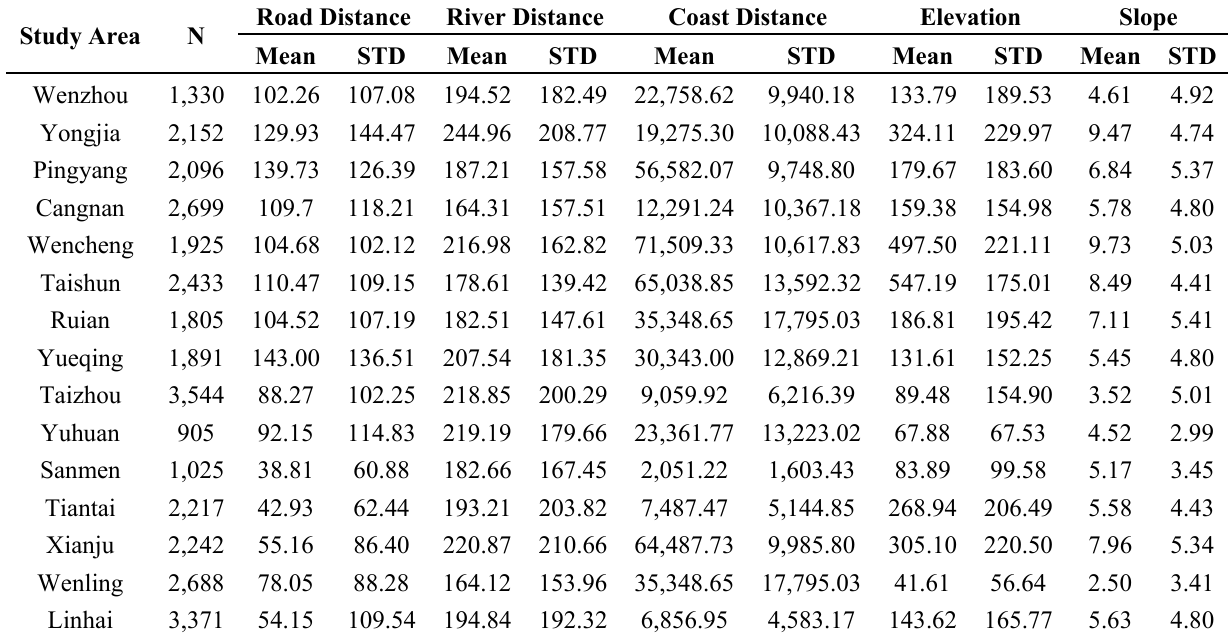
Table 1. Mean and standard deviation (STD) of settlement distance from road/river networks and topography of each county in Wen-Tai region,